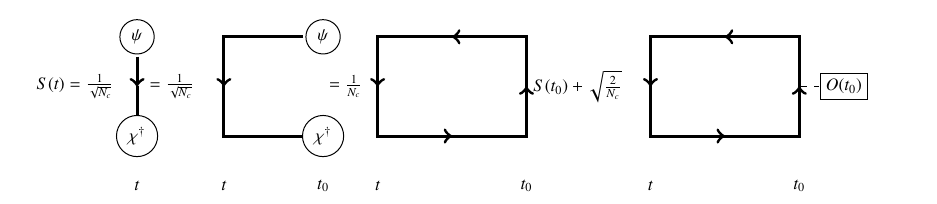
Figure 1. Backwards evolution of the singlet. We are using a birdtrack notation, more details in [1]